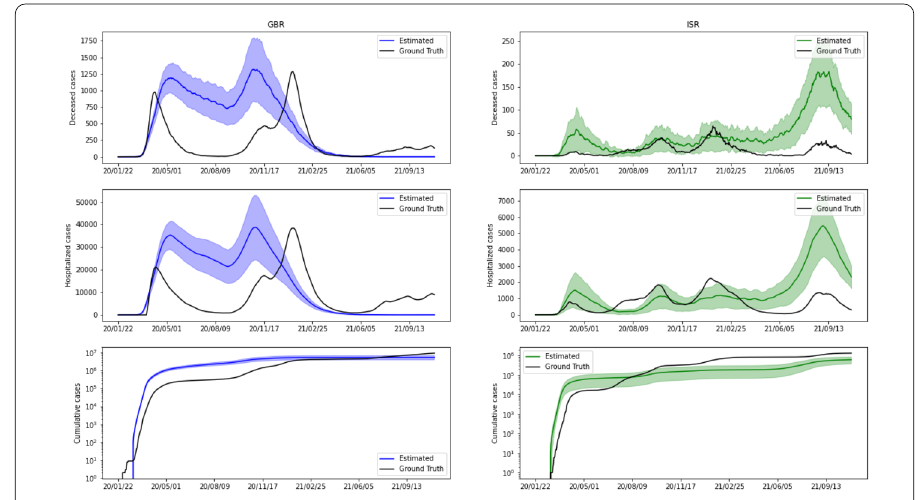
Figure 7 Final estimated solution. Left column: GBR; right column: ISR. Ground truth data is presented by a solid black line, while estimated numbers are presented in blue for GBR and in green for ISR — solid lines indicate the mean over 100 simulations, and the shaded area shows standard